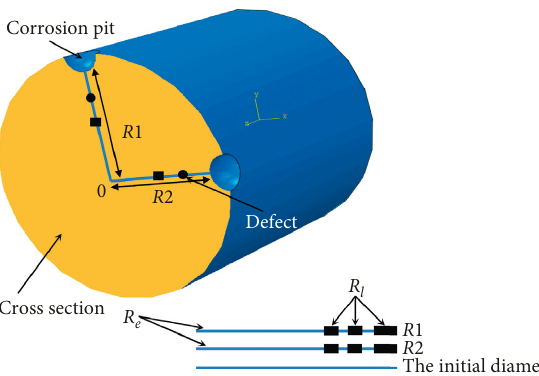
Figure 8: Schematic diagram of the CF damage model of high- strength steel